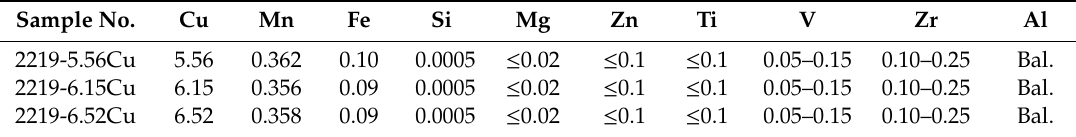
Table 1. Chemical compositions of experimental alloys, wt.%.